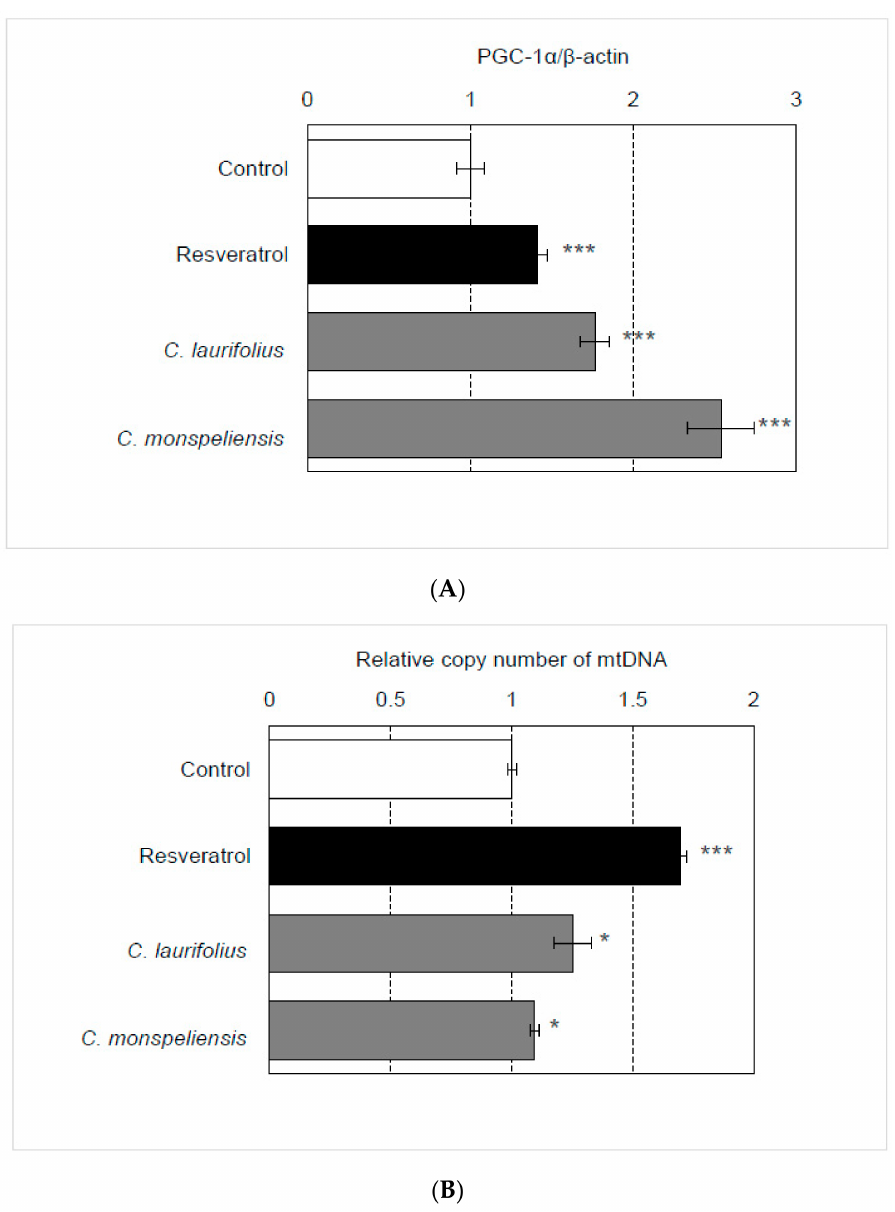
suggesting that these essential oils can enhance the function of the cell envelope and